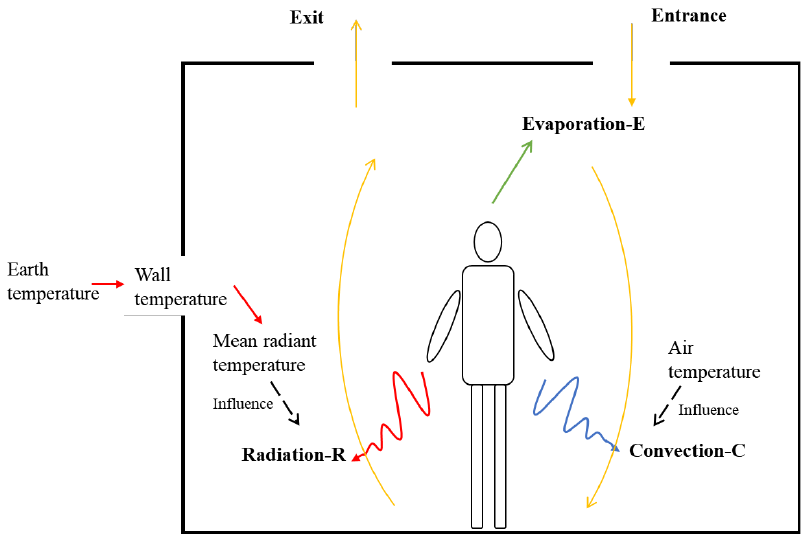
Figure 14. Influence of the underground space thermal environment on human body heat dissipation.